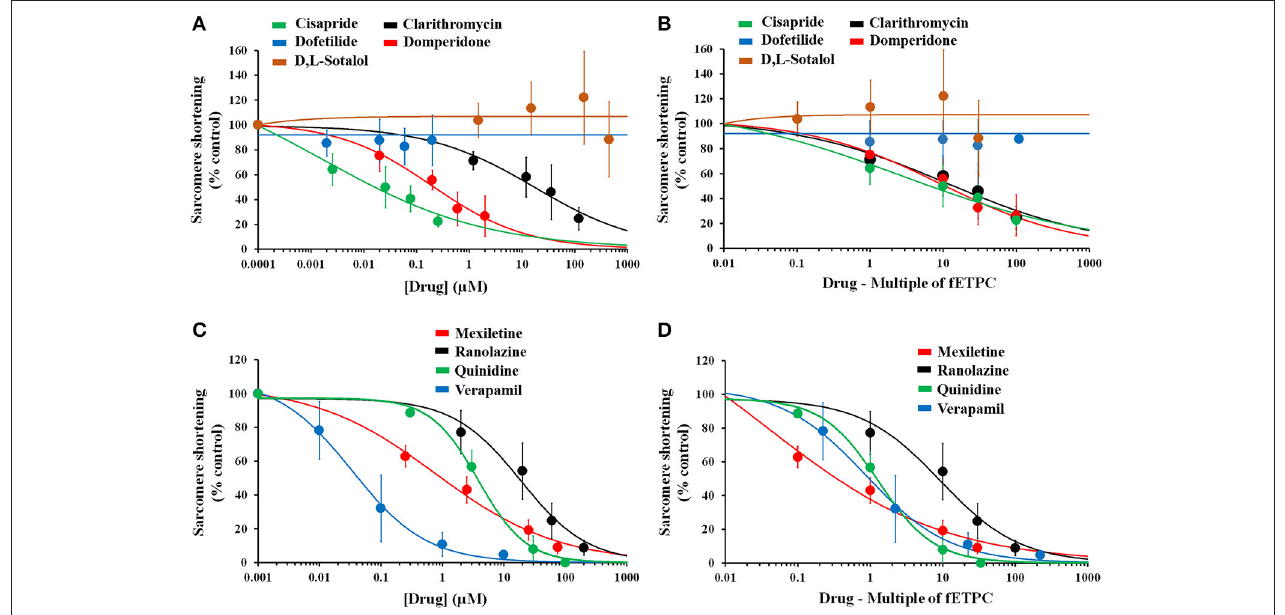
FIGURE 7 | Effects of positive and negative controls on human cardiomyocyte contractility. Drug-effect curves for sarcomere shortening are shown as a function of concentrations tested (A , C) or multiple of fETPCs (B , D) . The 0.0001 and 0.001 µ M represent the normalized vehicle data for drugs in (A) and (B) , respectively. IC50 ( µ M) and ratio (IC50/fETPC) values for the effects of multi-ion channel blockers on sarcomere shortening were found to be 0.02 and 8 for cisapride, 16 and 13 for clarithromycin, 0.2 and 10 for domperidone, 0.9 and 0.4 for mexiletine, 17 and 9 for ranolazine, 3.6 and 1 for quinidine, and 0.04 and 2 for